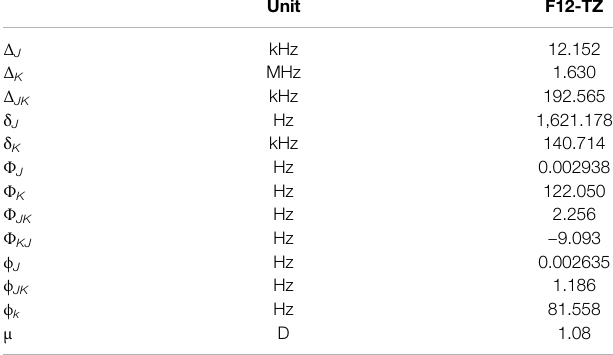
TABLE 9 | Geometry and rotational constants of AlH 2 NH 2 . TABLE 10 | Quartic and sextic constants of AlH 2 NH 2 .